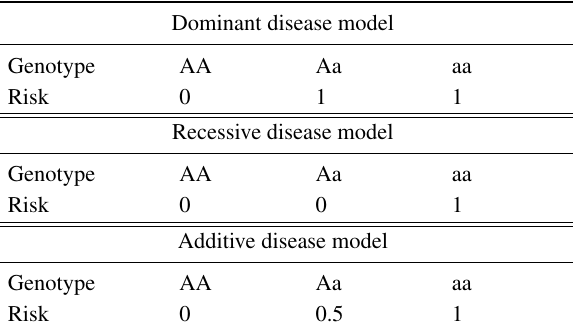
Disease models for single SNPs.